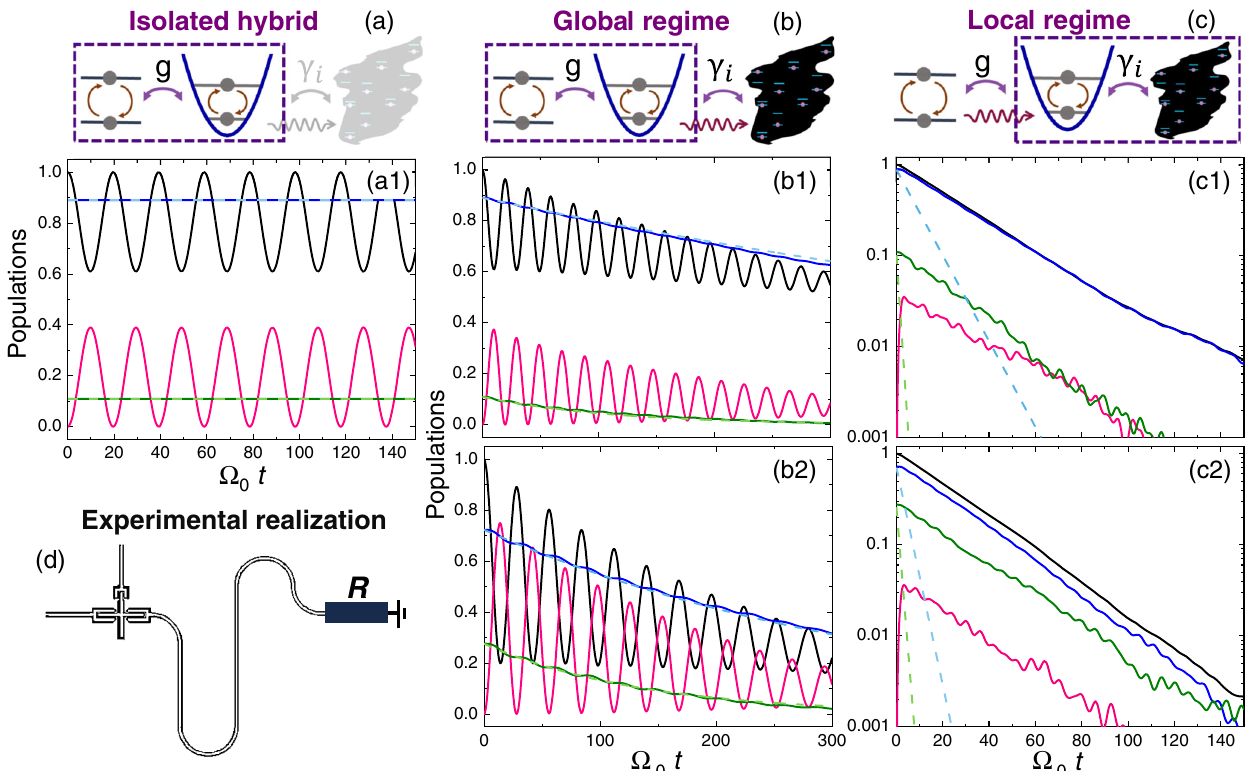
FIG. 3. Different relaxation regimes of a qubit coupled via a cavity to a heat bath. The qubit (alone) is initially prepared in its excited state. Here, the coupling between the qubit and cavity is ¯ g ¼ 0 . 1 , and the number of oscillators in the bath is N ¼ 10 4 with a flat energy spectrum of width Δ ω ¼ 2 Ω 0 . In (a1), (b1), and (c1), the qubit is detuned at D ¼ − 0 . 25 , and in (b2) and (c2) D ¼ − 0 . 1 . The black solid t Þj 2 , the red solid line the population of the cavity, j C t Þj 2 , the blue solid line the population in line is the population of the qubit, j C Q ð C ð the first eigenstate of the hybrid system, ρ 11 , and the green one that of the second eigenstate, ρ 22 . Finally, the light blue and green dashed lines are the predictions of the global model for ˜ ρ 11 and ˜ ρ 22 , respectively. In (a1), Γ 0 ¼ 0 ; i.e., it presents an isolated hybrid system, as shown schematically in (a), with populations ρ 11 ð¼ ˜ ρ 11 Þ and ρ 22 ð¼ ˜ ρ 22 Þ from the master equation [numerically from Eqs. (21)]. In both (b1) and (b2), Γ 0 ¼ 0 . 01 Ω 0 , which presents exponential decay of the population in hybridized states as expected for a global picture as shown schematically in (b). In (c1) and (c2), coupling to the bath is strong, Γ 0 ¼ Ω 0 , which leads to the breakdown of the global picture and entrance into the local regime with exponential decay of the qubit only [local picture, as shown in (c)]. (d) A possible physical realization of the